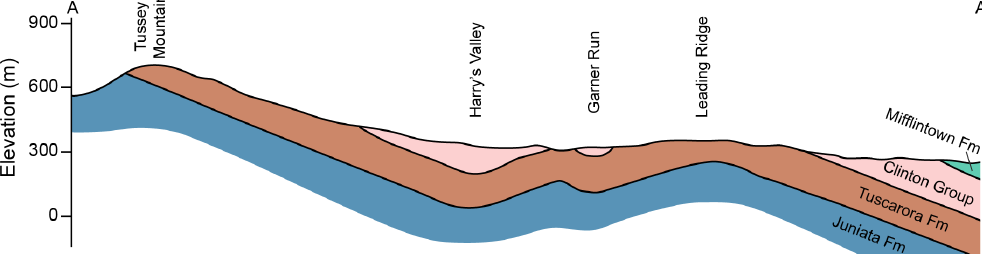
Figure 4. Geologic cross section of Garner Run subcatchment reproduced from Flueckinger (1969). Map units include Mifflintown (Middle Silurian), Clinton group (including Rose Hill formation), Tuscarora (Lower Silurian), and Juniata (Upper Ordovician). Cross section position is downstream from the Garner Run subcatchment (see Fig. 3) and locally preserves Clinton Group shales in the valley floor, overlying the Tuscarora Formation.